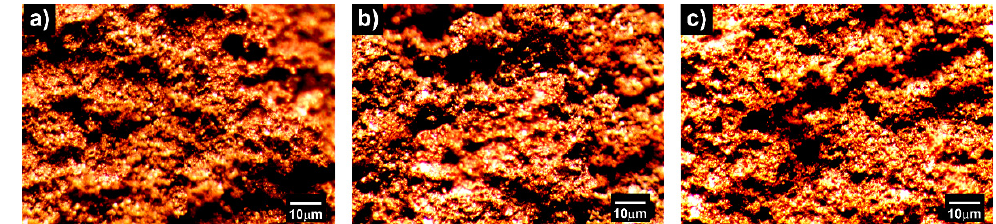
Figure 9. Images taken with a stereographic microscope from the fracture surface area of the com- posite ( a ) Pure aluminum, ( b ) Al-1 vol.% WC and ( c ) Al-1 vol.% mullite.